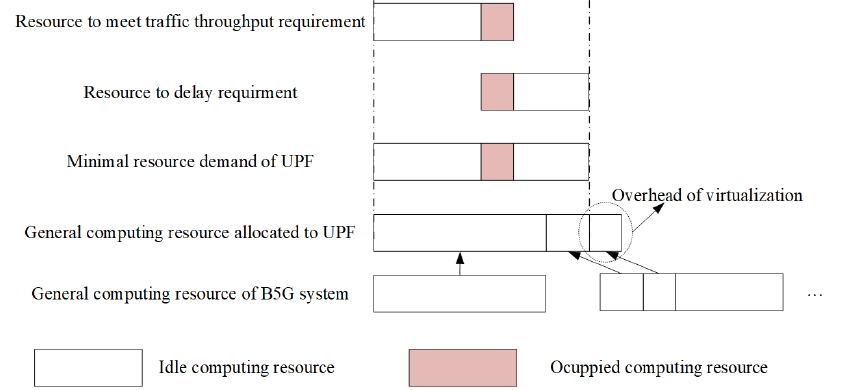
Figure 5. Virtualization of CN using the UPF as an example.